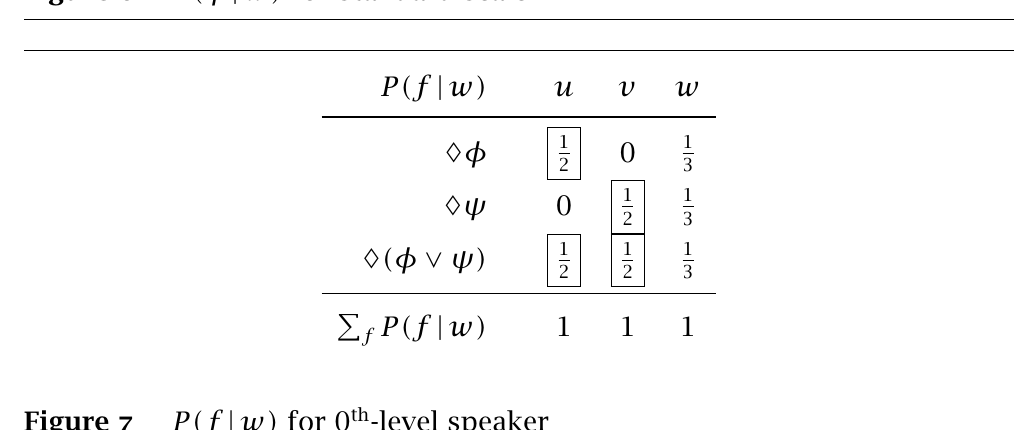
Figure 7 P(f | w) for 0 th -level